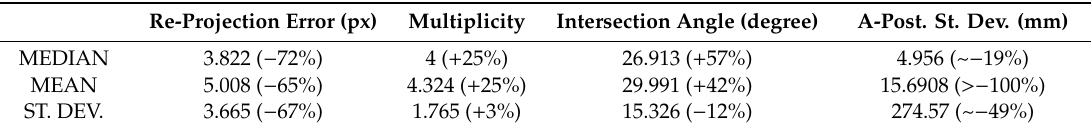
Table 13. Values of the quality parameters computed on the filtered sparse point cloud and average variation of the results.